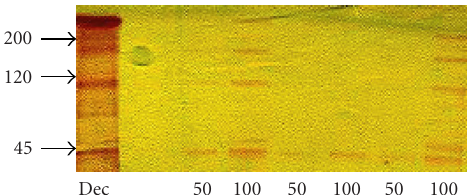
Figure 2. Gel electrophoresis of extracts, as described in “ma- terials and methods” and [4] on 3%–20% gradient gels, with 3% stacking gel. The left lane is a kaleidoscope M R marker for decorin with stated values to its left. The lanes are 1, skin B first extract (D); 2, skin B second extract (DD); 3, skin B third extract (DDD); lane 5 is authentic decorin; lanes 6–8 are as 2–4, but for skin C; silver